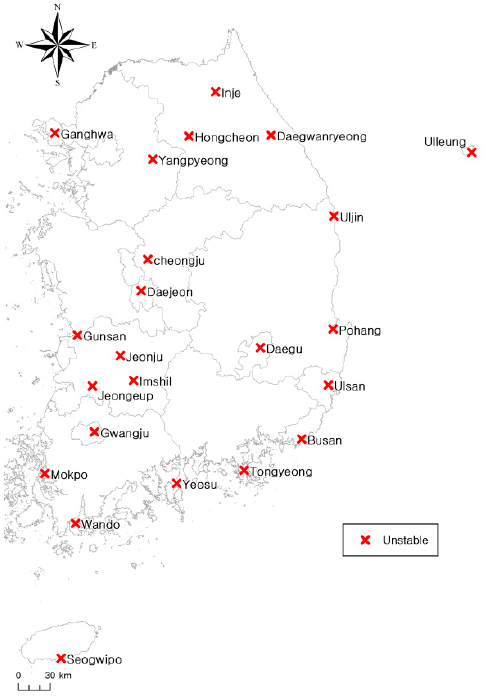
Figure 19. Stability test results using the climate change scenarios.